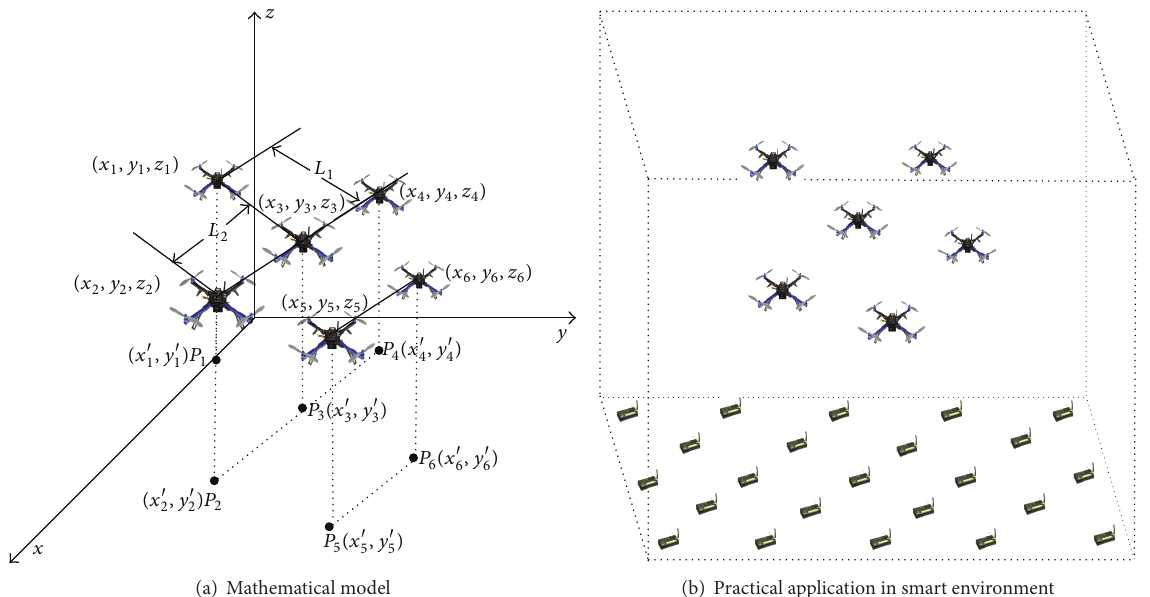
Figure 10: The model of formation control for quadrotor helicopters under the condition of different